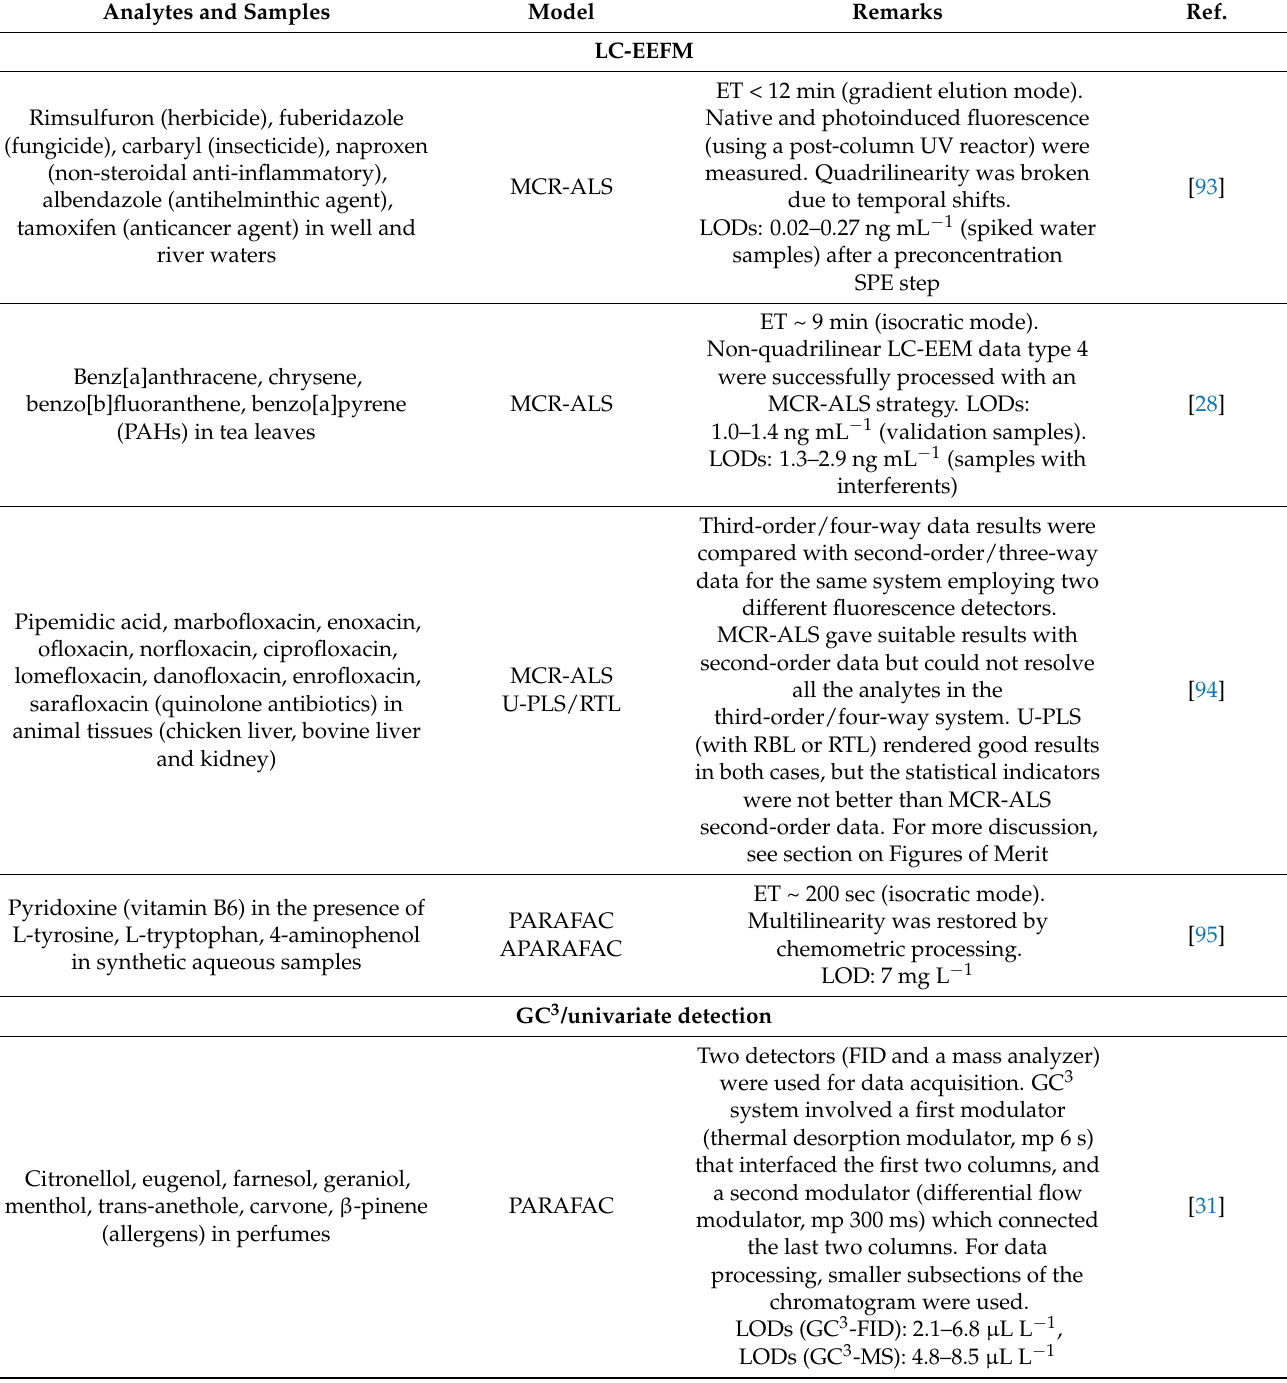
Table 2. Reports from 2018 to date based on chromatographic third-order/four-way data for quantitation